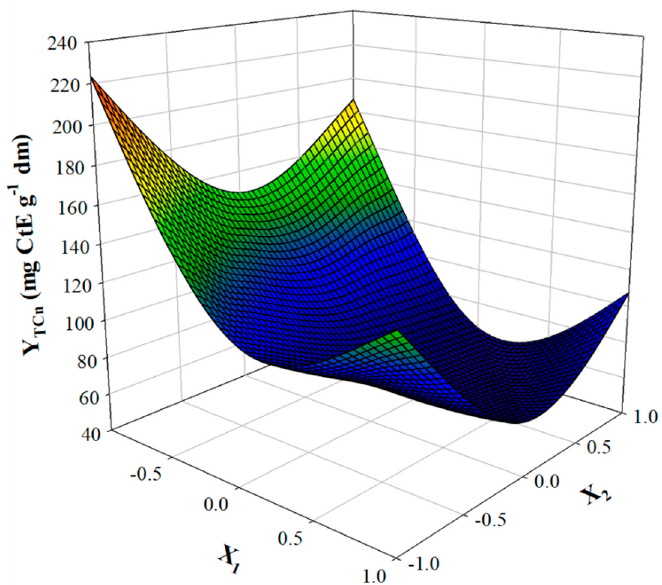
Figure 3. 3D Response surface plot illustrating the effect of the simultaneous variation of T and t on total carotenoid recovery yield from APP.